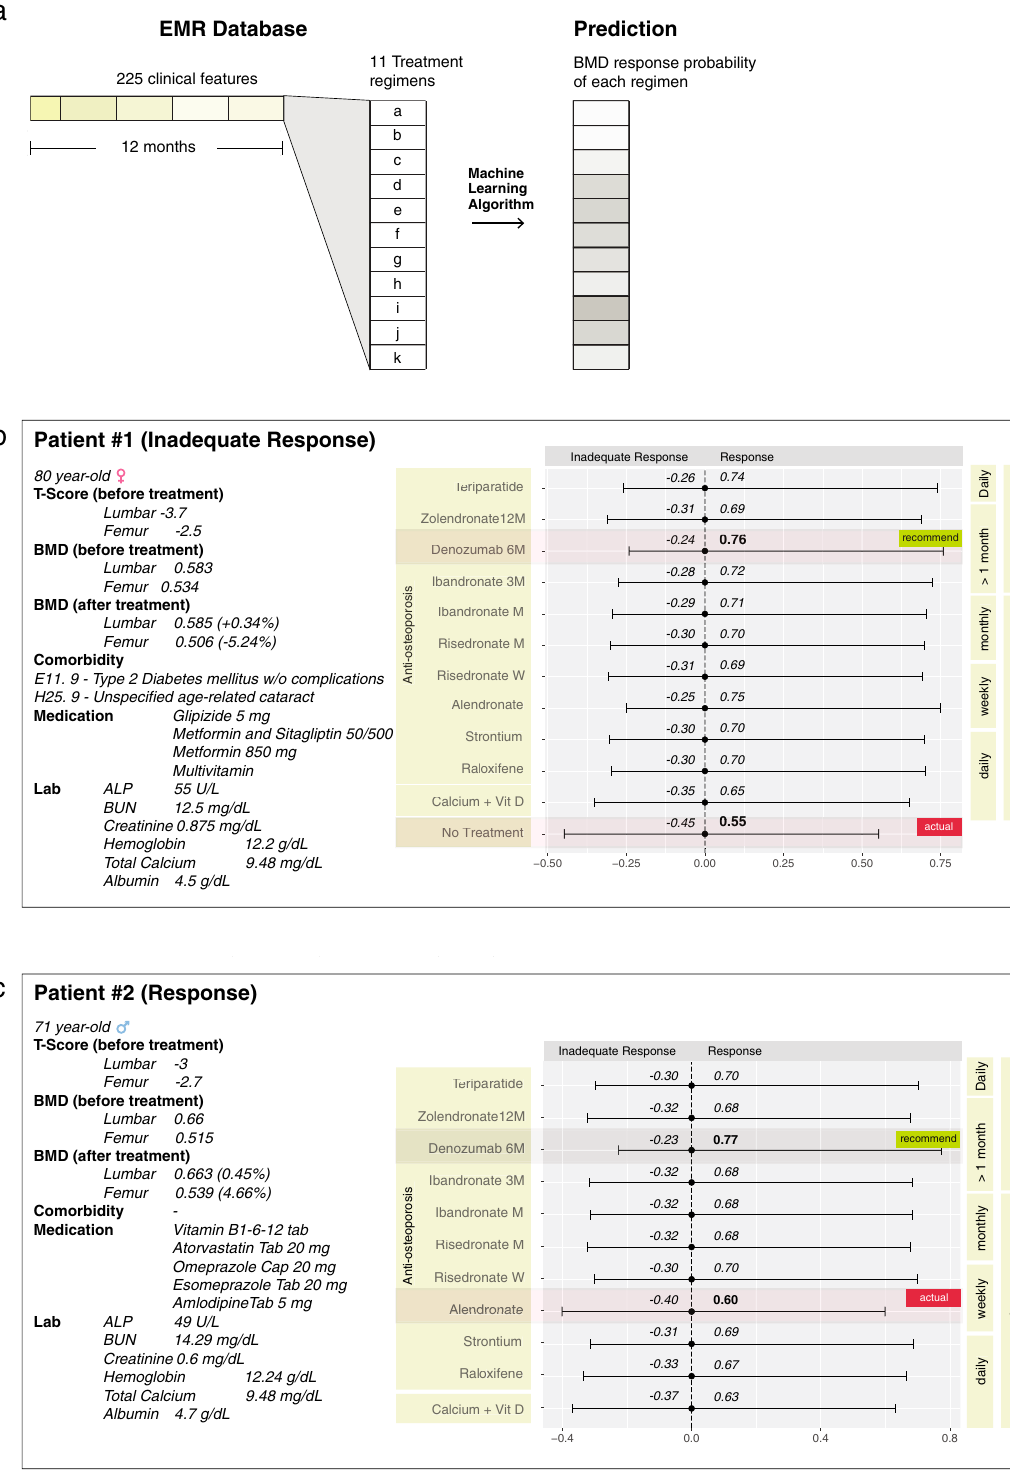
Figure 7. Individual BMD response prediction. ( a ) A set of 225 patient-specfic clinical information within 12 month prior to treatment was combined with an actual regimen and other regimens in order to predict BMD response. ( b , c ) The model predict probability of response of each regimen, and recommend the regimen which might provide a highest-probability according to the model